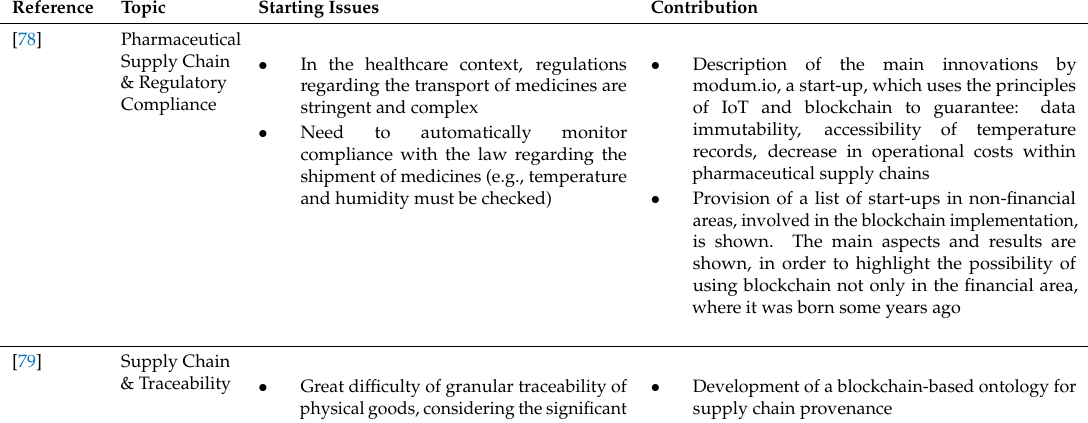
Table 6. Analysis of the most relevant documents belonging to C 1 (part